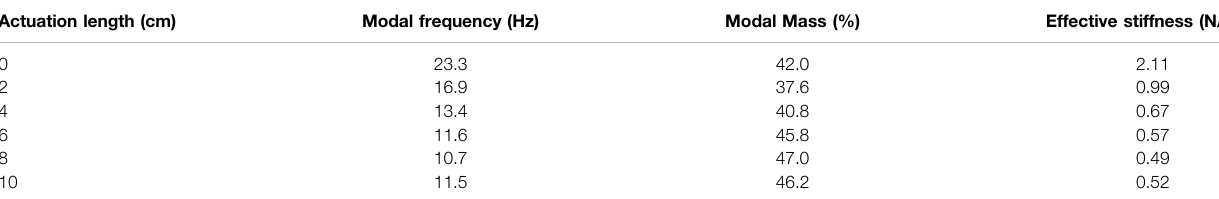
TABLE 2 | Calculation of effective stiffness (N/mm) of the OPB structure at different stages of rolling. Actuation length (cm)